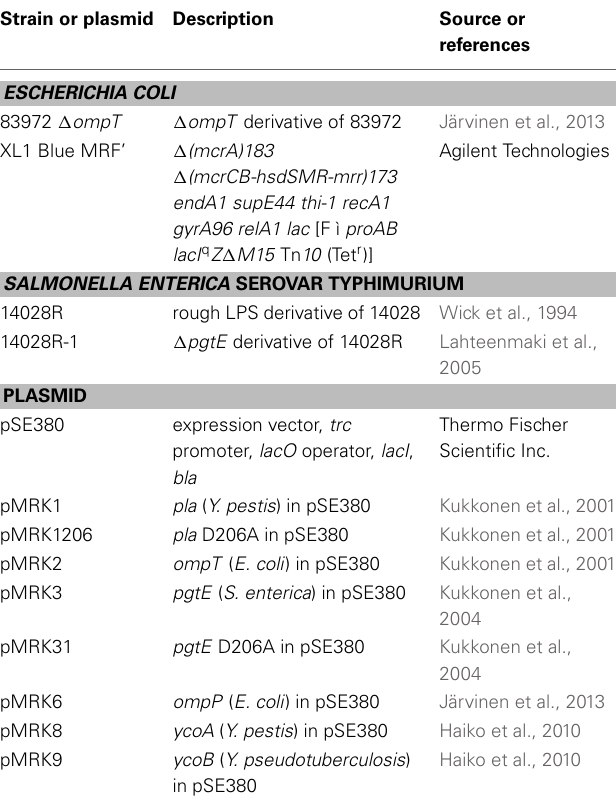
Table 1 | Bacterial strains and